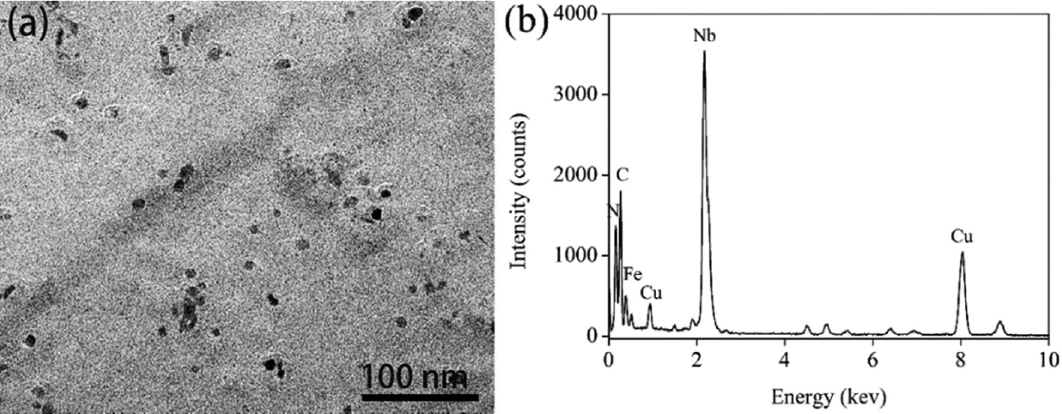
Figure 10: Nb ( C, N ) precipitates morphology ( a ) and EDS analysis result ( b ) of steel 4# strained at